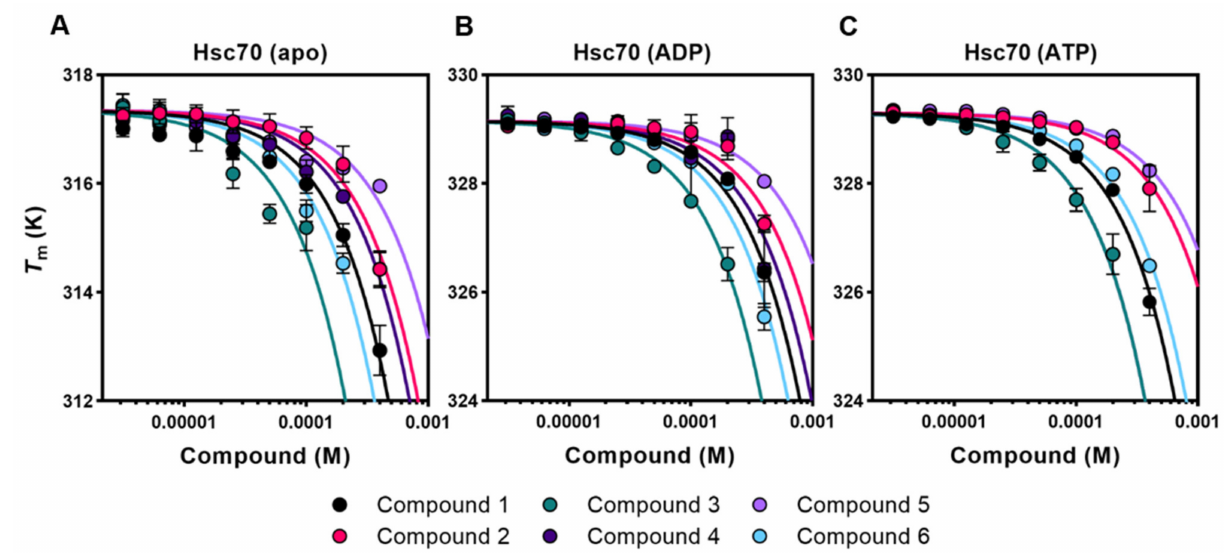
Figure 2. Selected compounds also affect the thermal stability of free and nucleotide-bound Hsc70. ( A – C ) Titrations of compounds 1–6 against apo-Hsc70 ( A ), Hsc70-ADP ( B ), and Hsc70-ATP ( C ). For fitting of the data, see Materials and Methods. The name, chemical structure, and molecular weight of these compounds are shown in Table 1 and Figure S1.